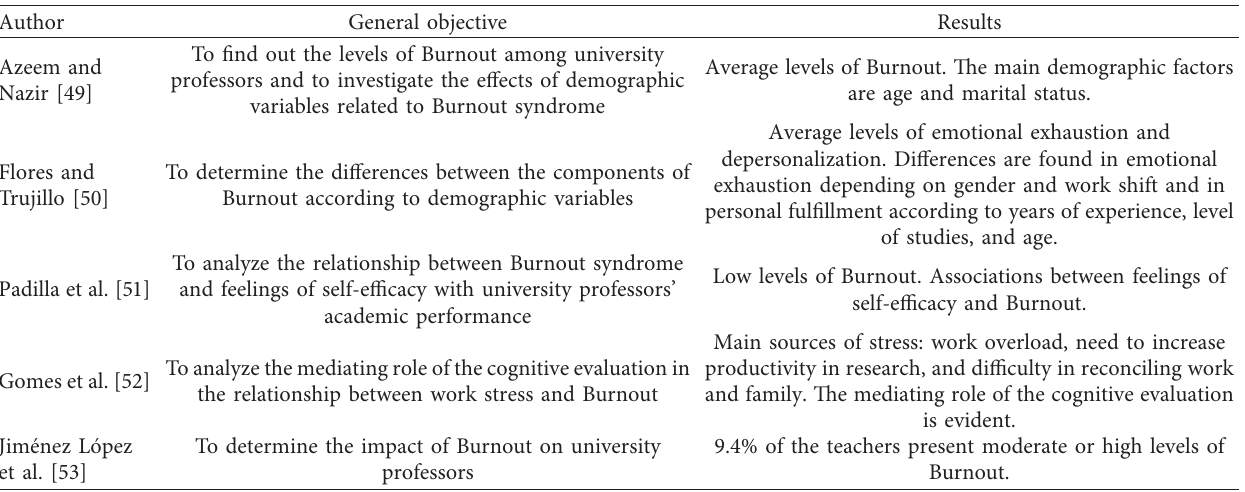
Table 4: List of articles